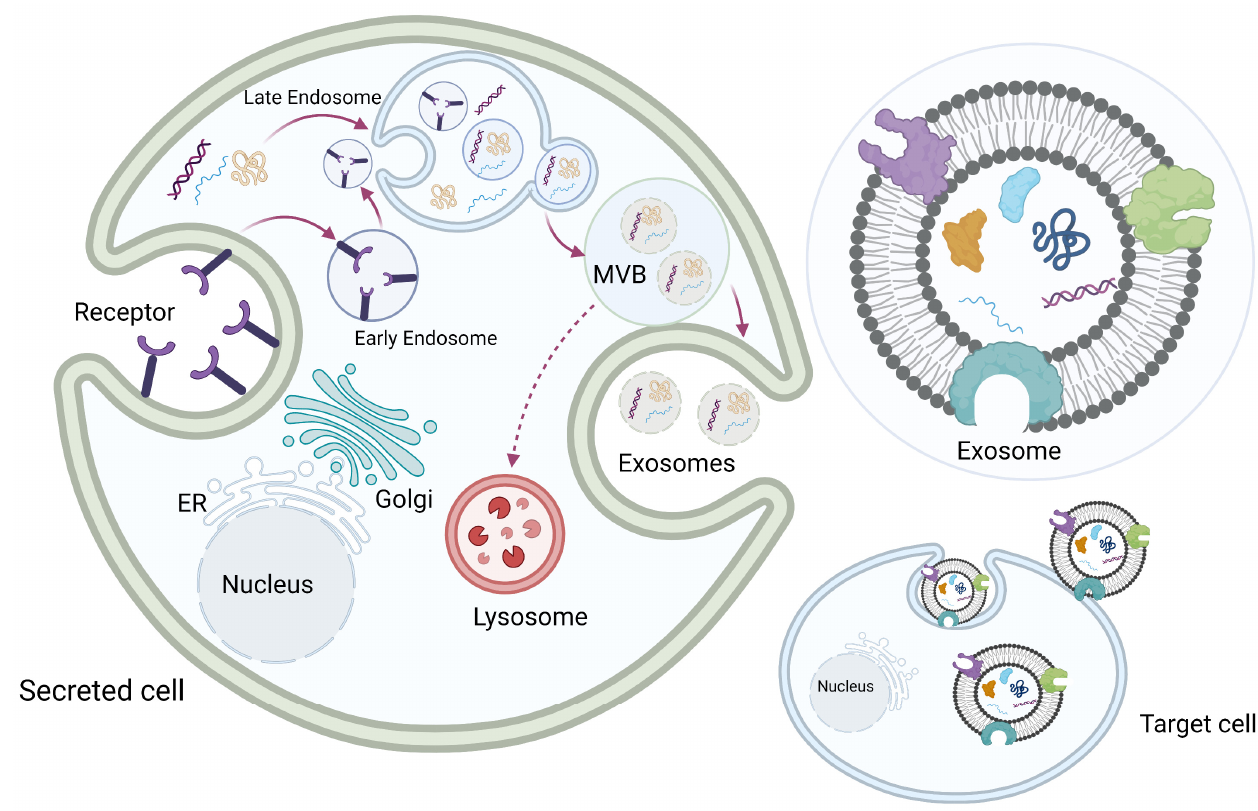
Figure 2. Exosome biogenesis. Exosome biogenesis begins with invagination of the cellular plasma membrane to form early endosomes. Early endosomes then mature into late endosomes, and the invagination of the endosome membrane forms multiple intraluminal vesicles inside the endosome, which becomes a multivesicular body (MVB). Each intraluminal vesicle inside the MVB encloses part of the cytosol, including various proteins and nucleic acids. The MVBs then fuse with the plasma membrane, and exosomes are released into the extracellular space. Some MVBs fuse with the lysosomes to be degraded. Original photo created with BioRender.com.